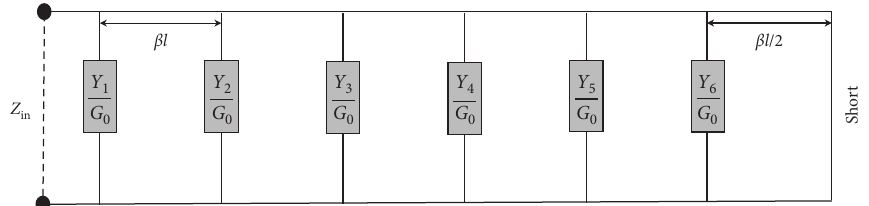
Figure 7: Equivalent circuit model of slotted